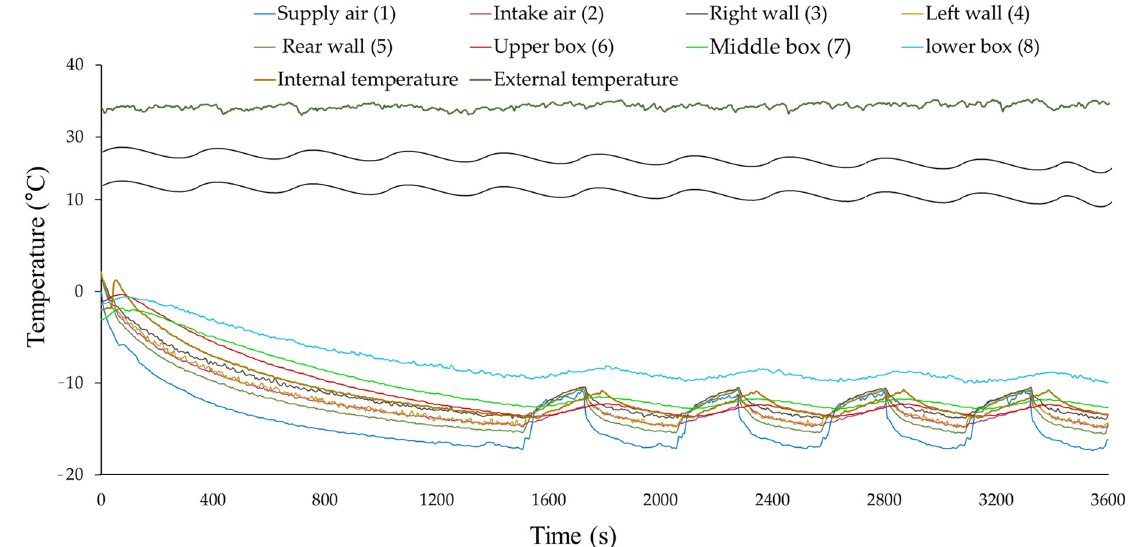
Figure 5. Temperature change in the refrigerated body with loading pattern (1): air (supply and intake fan), wall (5 cm from left, right, and rear wall), boxes (inner center point of upper, middle, and lower boxes). Table 1. The lower temperature limits of measurement points (setting temperature: − 15 ◦ C).